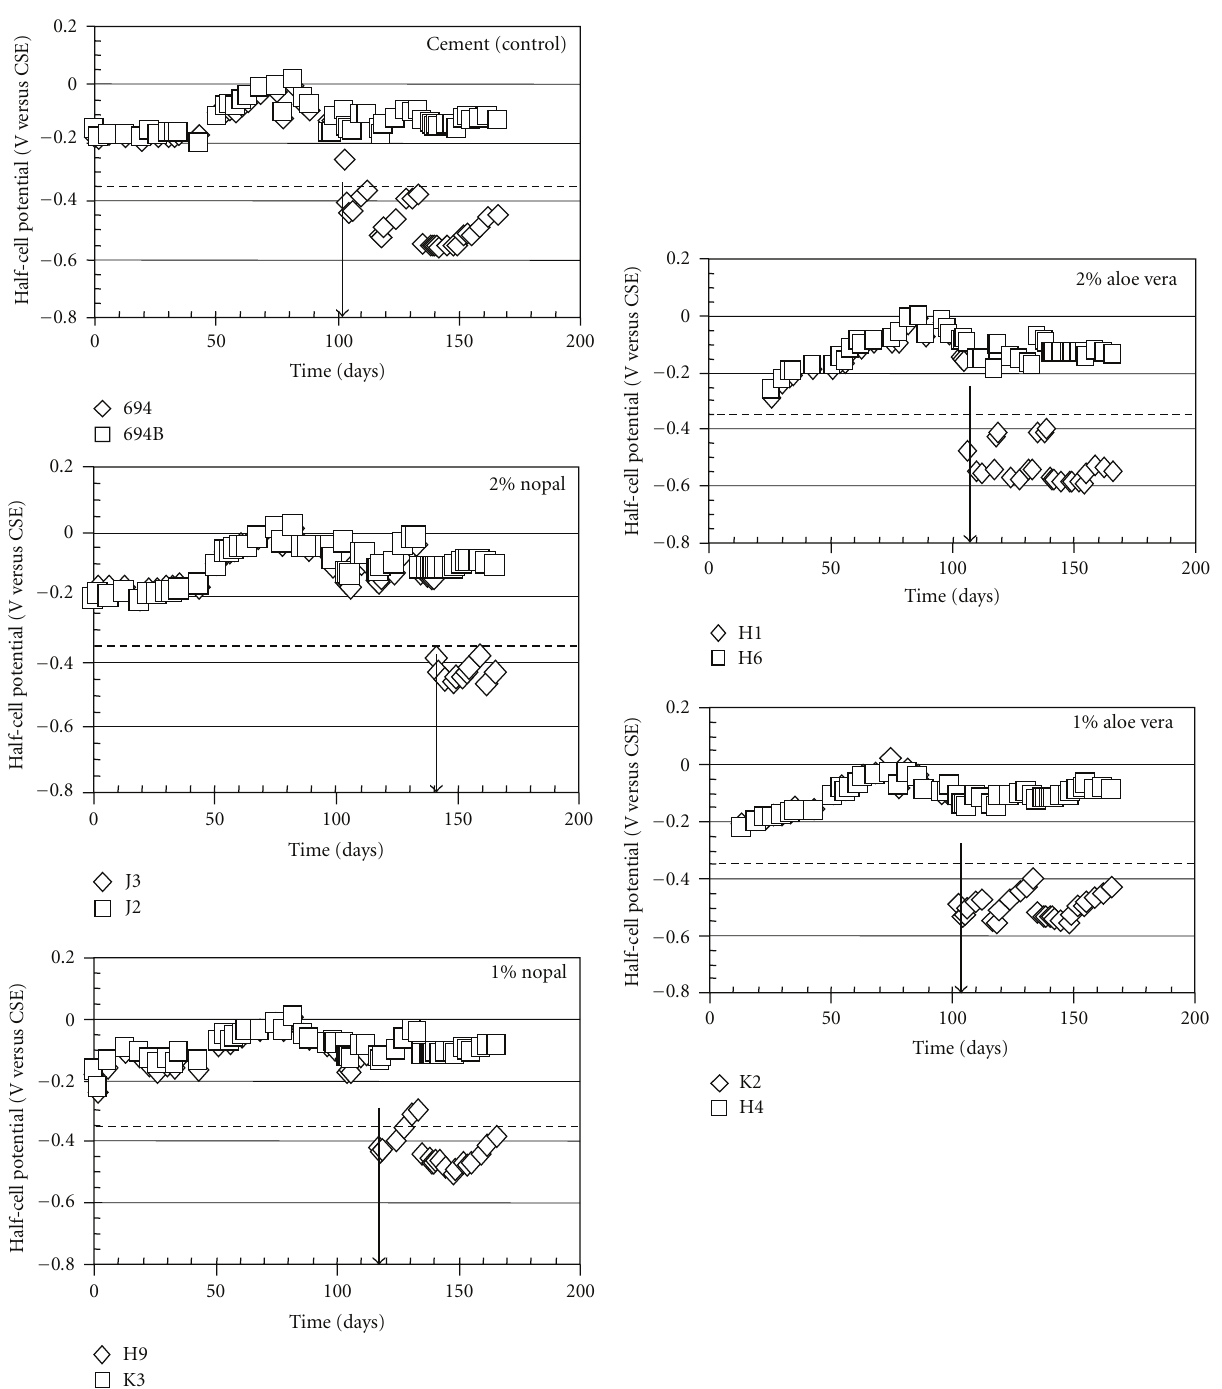
Figure 6: Half-cell potentials versus time of all concrete prisms tested. The arrow represents the time of corrosion initiation (or T i ). in concrete with additions. Special emphasis could be taken to the average data for 2% Nopal replacement concrete, where the R P estimate was high ( ∼ 2000 K Ω -cm 2 average) up to 140 days of testing time (after the 3rd wet cycle). This will give smaller apparent corrosion rates of steel in chloride- contaminated concrete when Nopal and Aloe Vera are added to the concrete.